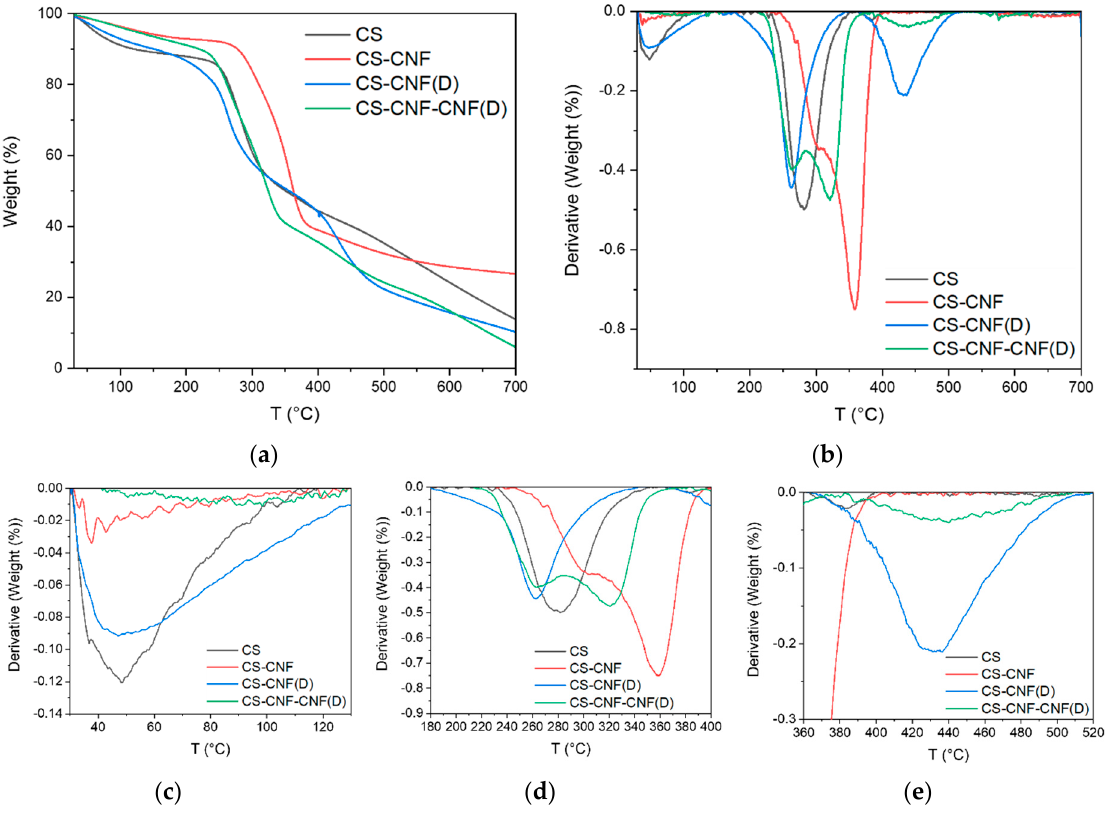
Figure 9. ( a ) TGA curves, ( b ) the first derivative of TGA curve, ( c ) display of the first mass loss area, ( d ) display of the second mass loss area, and ( e ) display of the third mass loss area for CS membranes with CNF and CNF(D) fillers. Table 3. Temperature areas of mass loss and percentage of mass loss for CS membranes with CNF and CNF(D) fillers determined by TGA analysis.